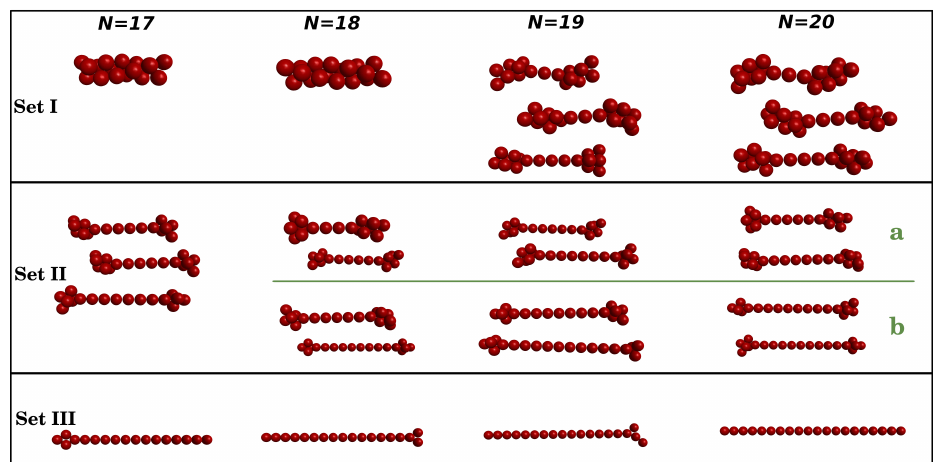
Figure 6. Main structural motifs from Set I, Set II and Set III of larger colloidal clusters ( N = 17–20). For N = 18–20, structures from Set II are separated into Set IIa and Set IIb (the latter are higher energy than the former ones). See the text for